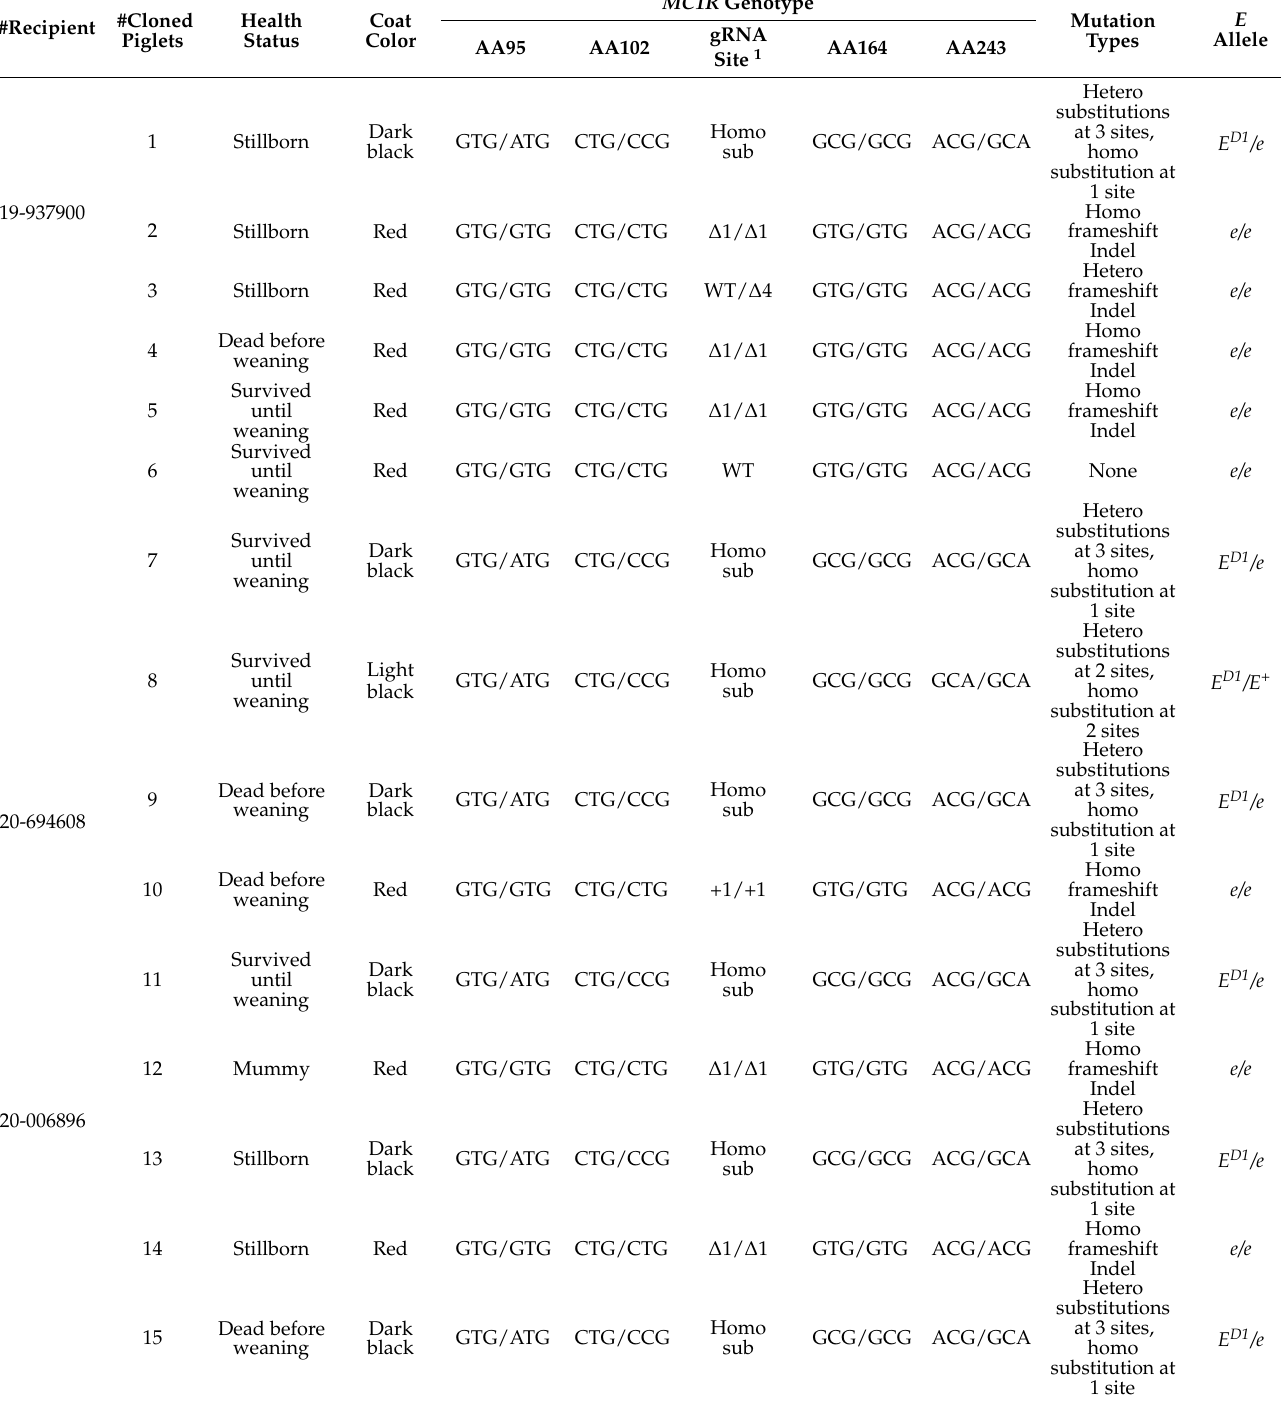
Table 2. Phenotypes and genotypes of cloned